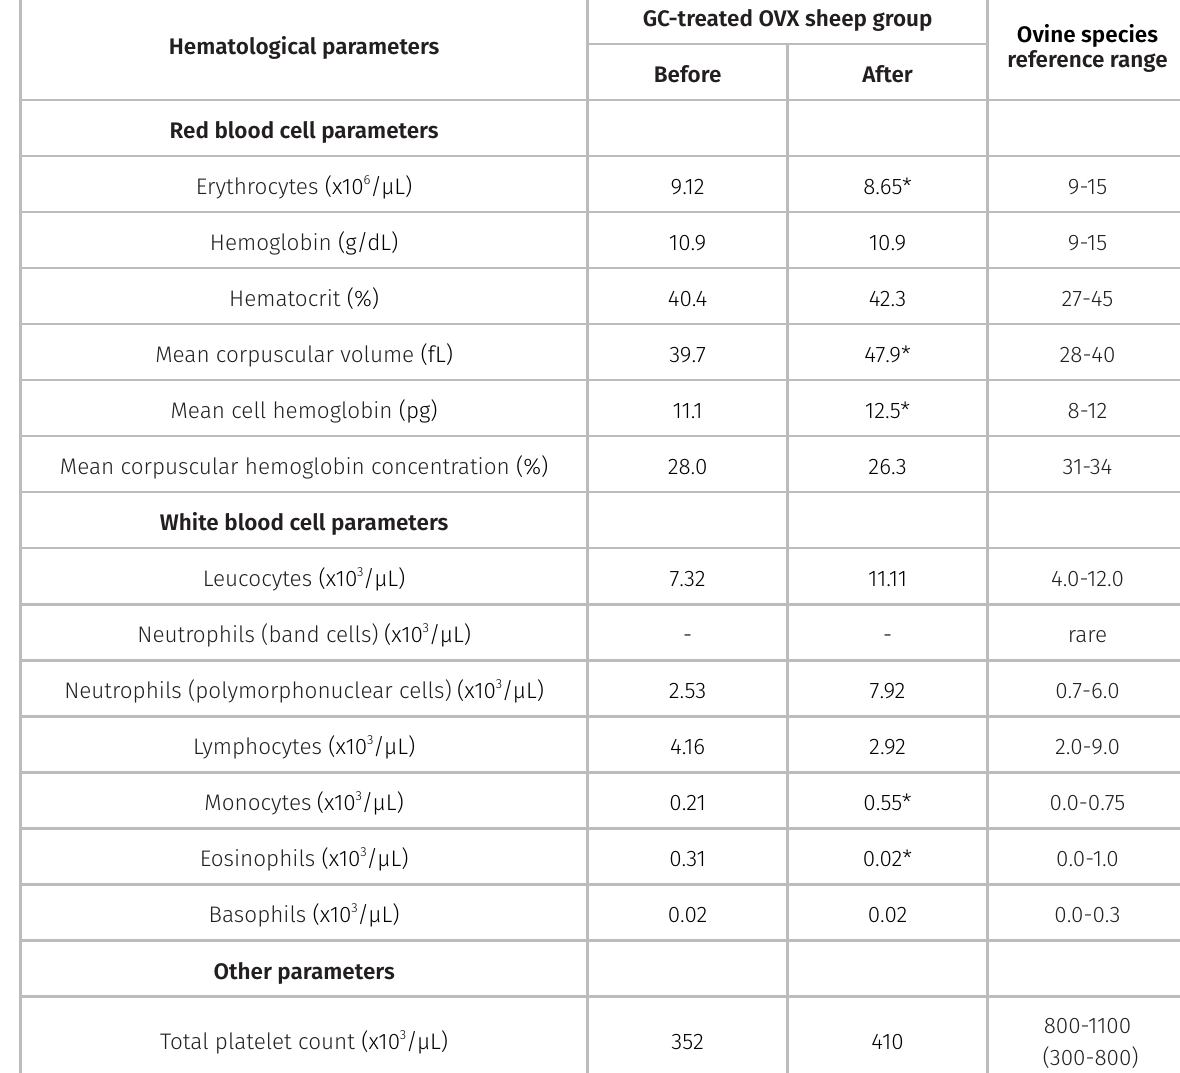
Table I. Hematological parameters before and after OVX and exogenous GC administration in sheep (median values) and reported reference range for ovine species [reference intervals from Byers & Kramer (2010) and Meyer & Harvey (1998) (between